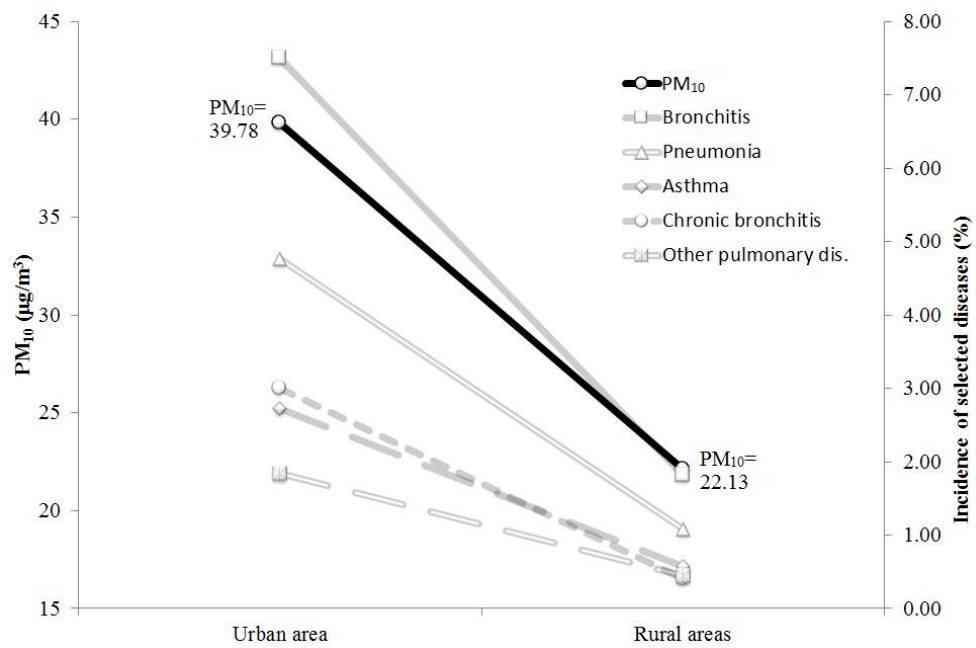
Figure 2. Incidence of selected respiratory diseases in the city and control groups on a background of the five-year mean concentration of PM 10 in the urban area and considered rural areas.